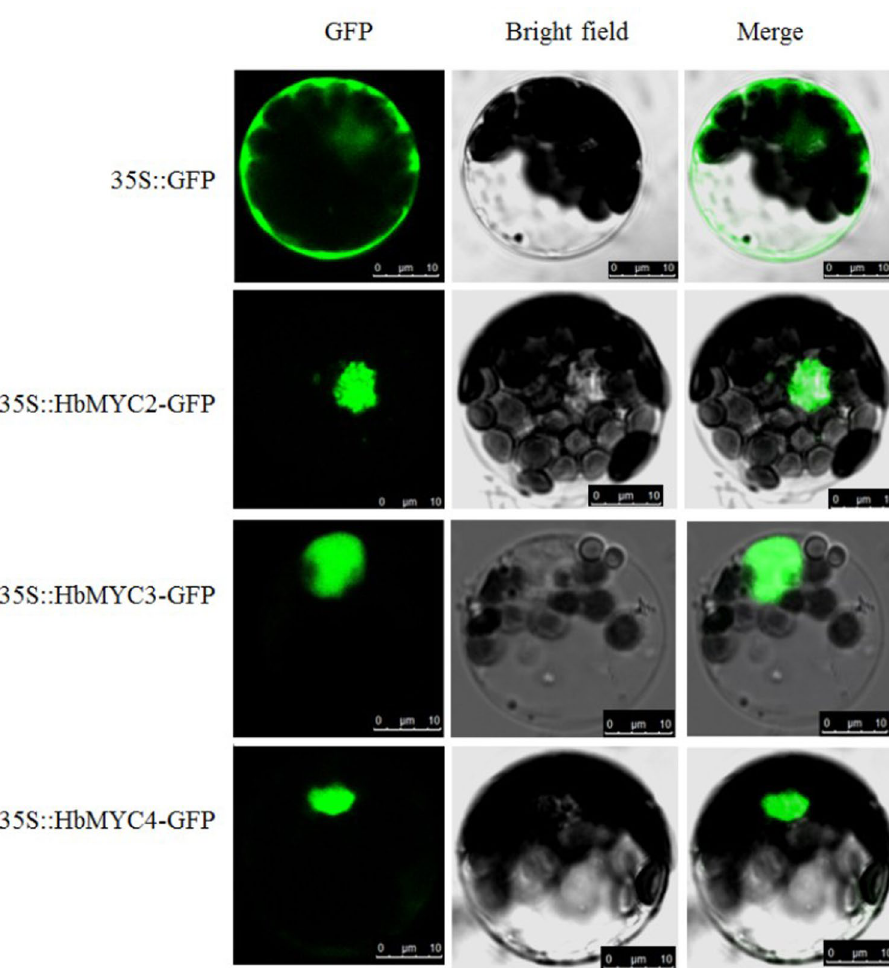
Figure 4. Subcellular localization of HbMYCs. Protoplasts of Arabidopsis leaf epidermis transiently expressing 35 S:HbMYC2-GFP , 35 S:HbMYC3-GFP and 35 S:HbMYC4-GFP fusion proteins observed under a laser scanning confocal